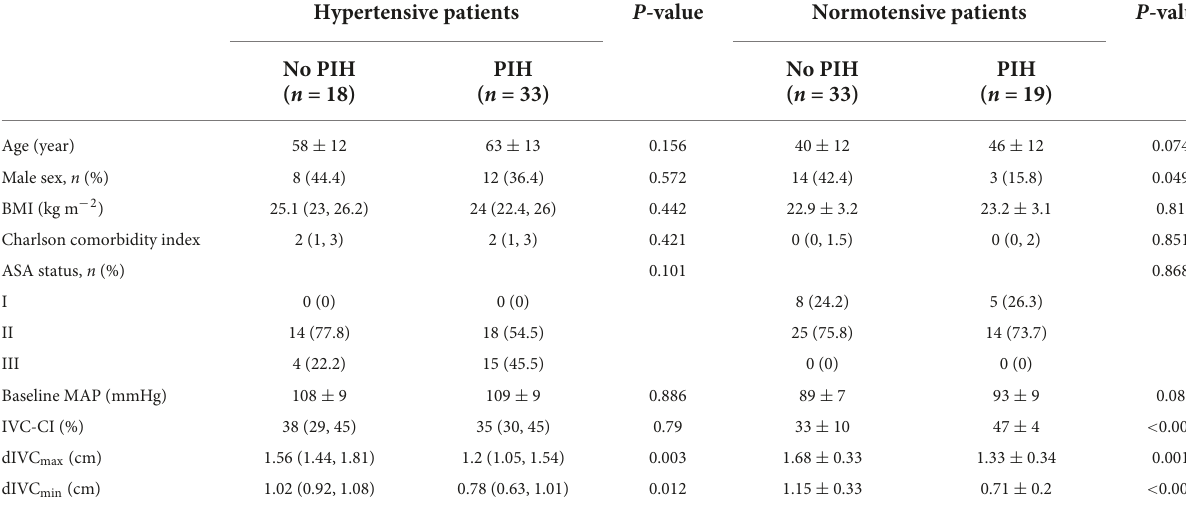
TABLE 2 Baseline characteristics and ultrasound-based inferior vena cava (IVC) parameters in patients with versus without post-induction hypotension (PIH). Hypertensive patients P -value Normotensive